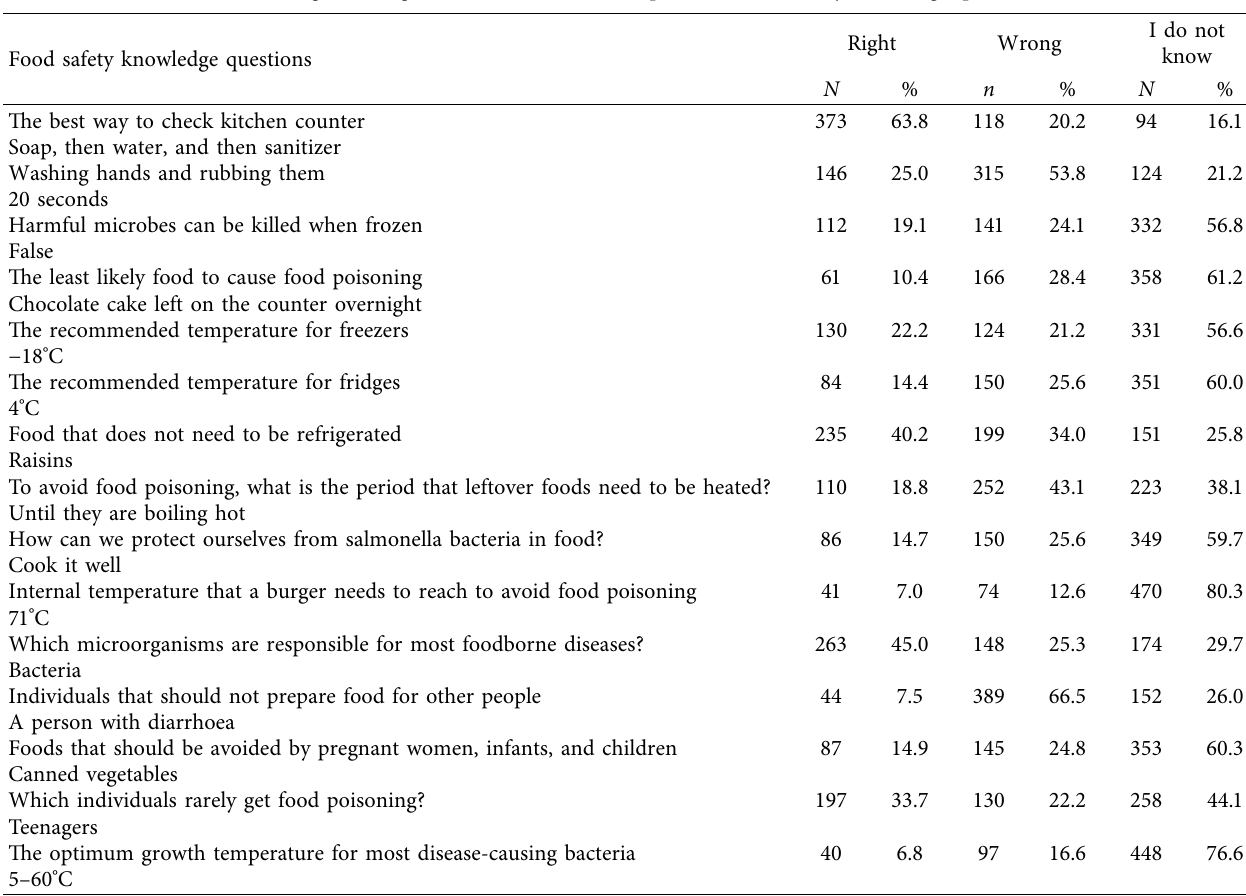
Table 4: Right, wrong, and “I do not know” responses to food safety knowledge